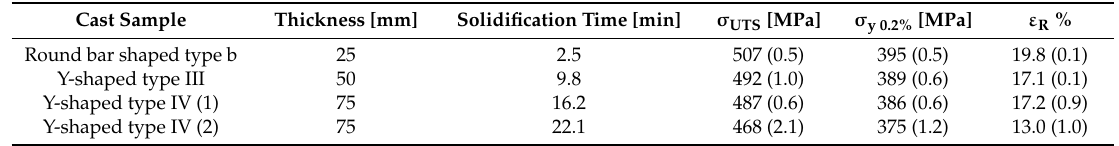
Table 2. Tensile test results (mean values and standard deviation (in brackets)) of specimens taken from cast samples as a function of section thickness and corresponding solidification time.